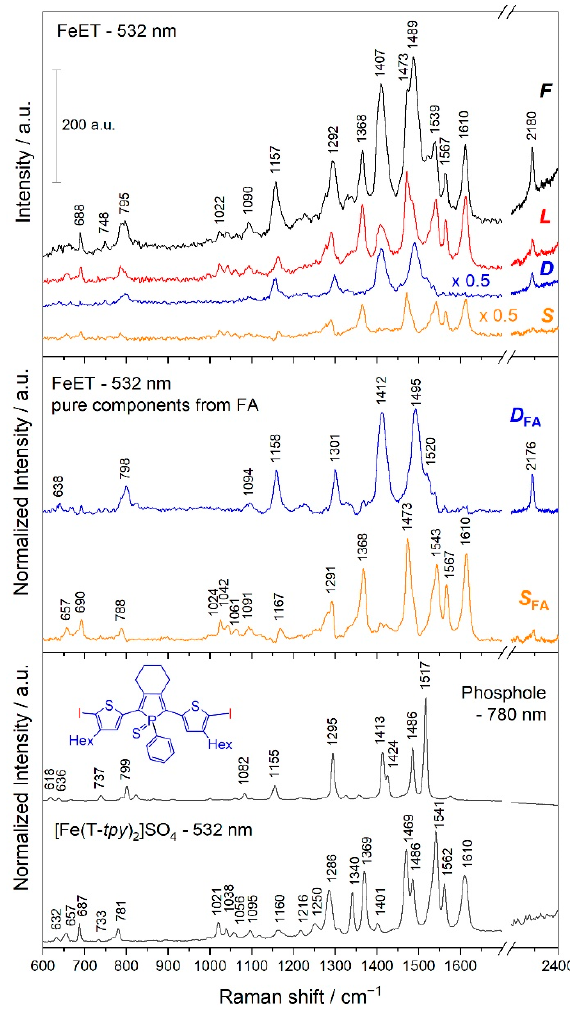
Figure 5. Comparison of relevant RS: ( Top ) : the first ( F ) and last ( L ) RS of the FeET (532 nm) series and RSs of the disappearing ( D ) and stable ( S ) components obtained by the subtraction method; ( Middle ) : pure spectral components obtained by factor analysis (FA) of the whole spectral set; ( Bottom ) :off-resonance RS of the precursor central unit and RRS of [Fe(T- tpy ) 2 ]SO 4 complex (T- tpy stands for 4 ′ -(2-thienyl)terpyridine).